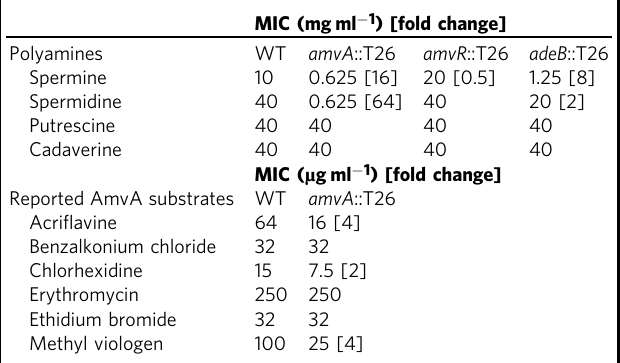
Table 1 Polyamine MIC changes in amvA , amvR and adeB mutants of A. baumannii